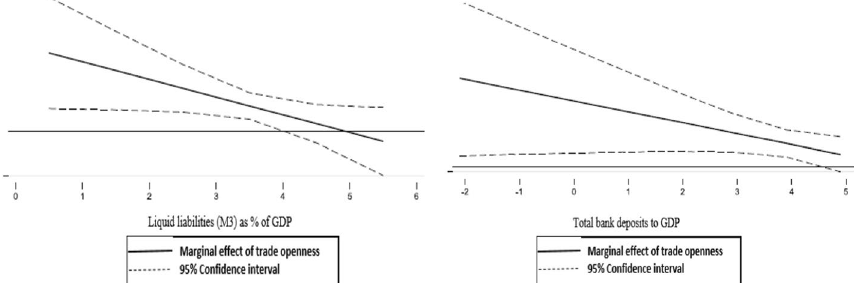
Fig. 11 Effects of trade openness on CO 2 emissions as financial development changes. Dependent variable: